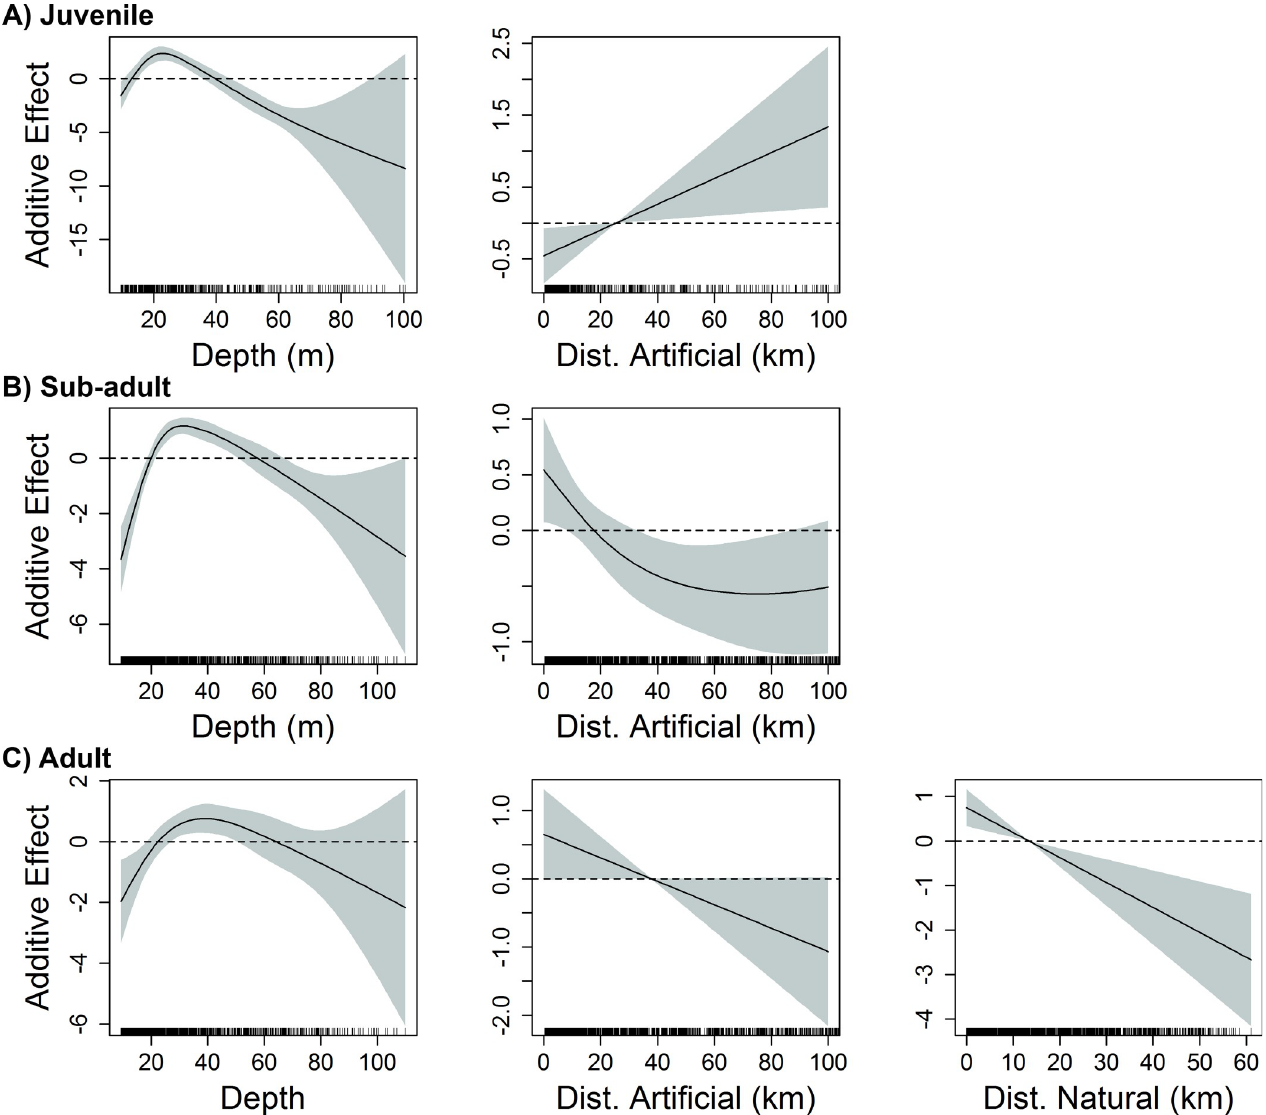
Fig 3. Influence of benthic habitat variables on red snapper abundance in the eastern GoM. Response plots from final generalized additive models show the influence of depth (m), distance to artificial structure (Dist. Artificial), and distance to natural hard bottom habitat (Dist. Natural) on the abundance of A) juvenile (age-0), B) sub-adult (age-1-2), and C) adult (age-2+) red snapper over unconsolidated bottom in the eastern GoM. Solid lines represent smoothed values, and shaded areas represent 95% confidence intervals. Dashed lines are included at y = 0.